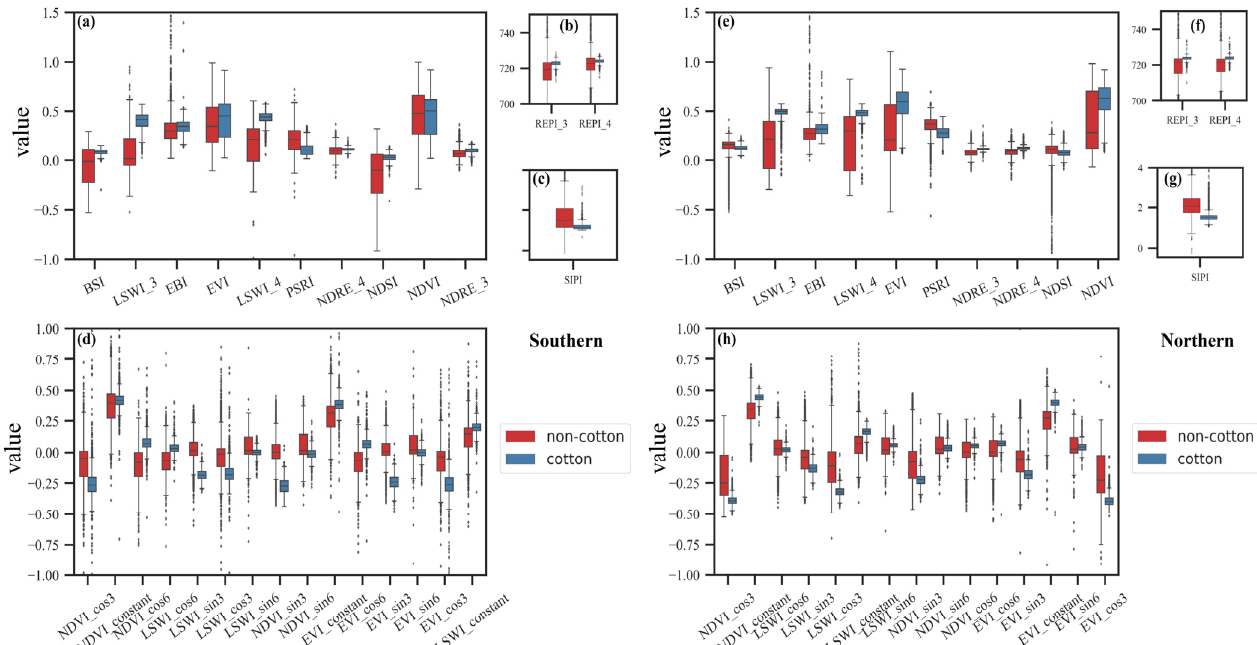
Figure 5. Boxplots of each feature for cotton and non-cotton in southern and northern Xinjiang. LSWI_3 and LSWI_4 represent LSWIs that are composited within FLS and BDS, respectively. NDVI_cos3 refers to the cos (3 π t) term coefficient of the NDVI time series, while NDVI_constant corresponds to the constant term coefficient of the NDVI time series. The remaining variables hold similar meanings. ( a – c ) and ( e – g ) demote the representative phenological stages features in southern and northern Xinjiang, respectively, ( d ) and ( h ) represent harmonic coefficients in southern and northern Xinjiang,